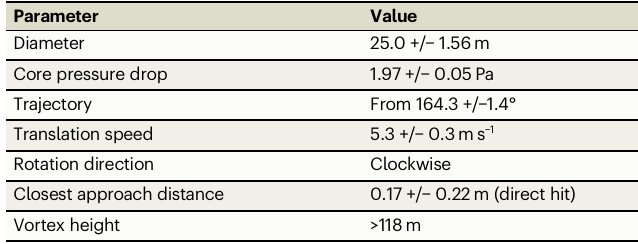
Table 1 | Derived vortex parameters for the dust devil at 11.02 LTST on September 27, 2021 Parameter